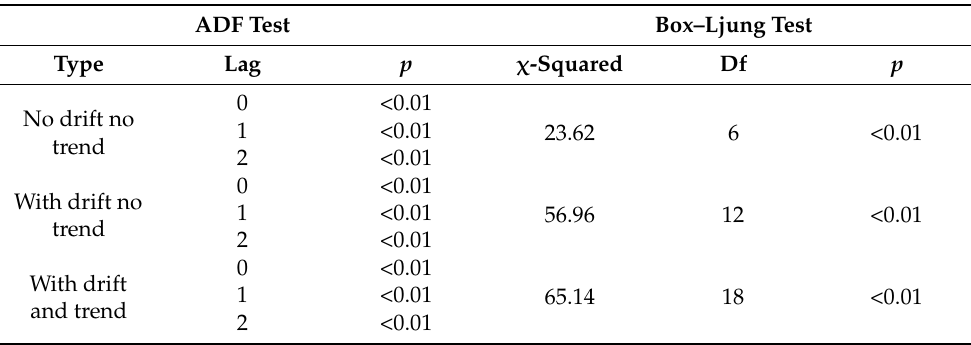
Figure 3. ACF and PACF plots of mumps and difference mumps sequences. Table 2. ADF and Box–Ljung tests for mumps after difference.